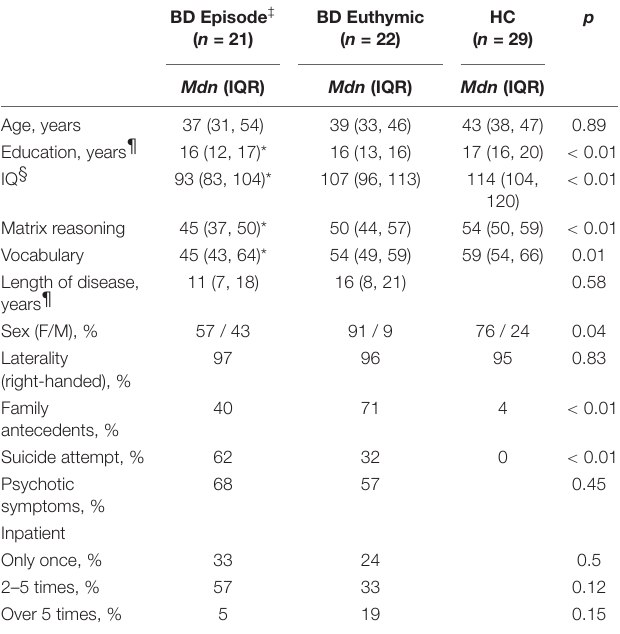
TABLE 1 | Characteristics of the